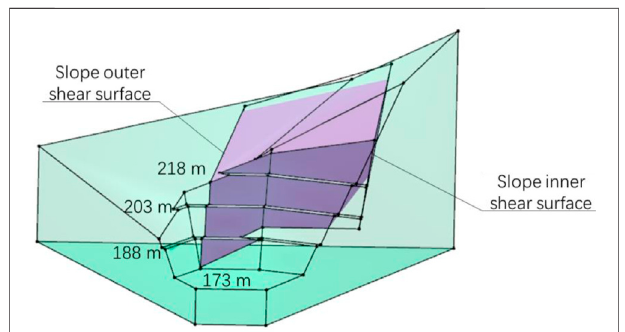
FIGURE11| Theshapeofthisblocksuggeststhatsupportisneededon the upstream slope of the dam.